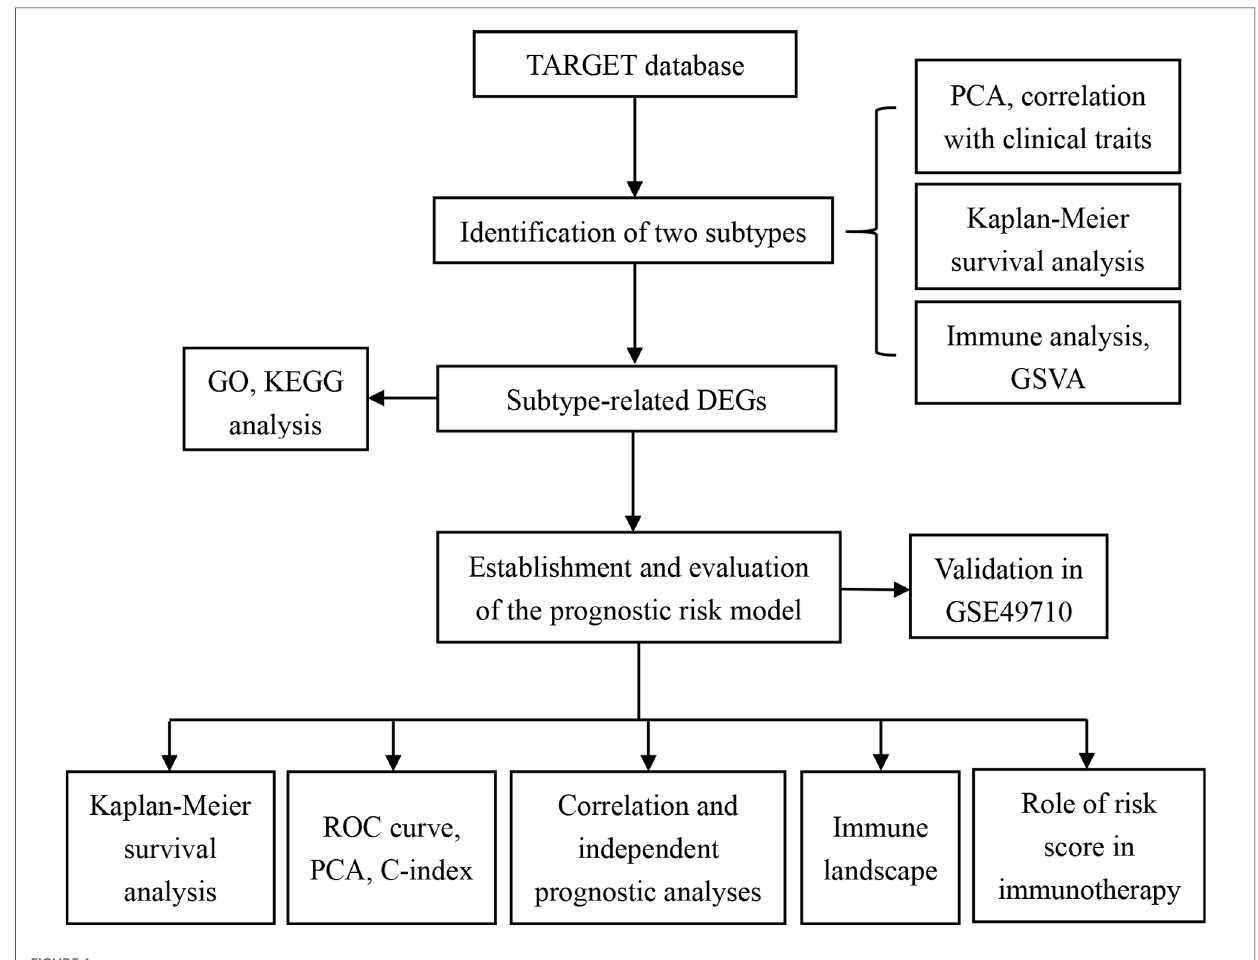
FIGURE 1 The fl owchart of this